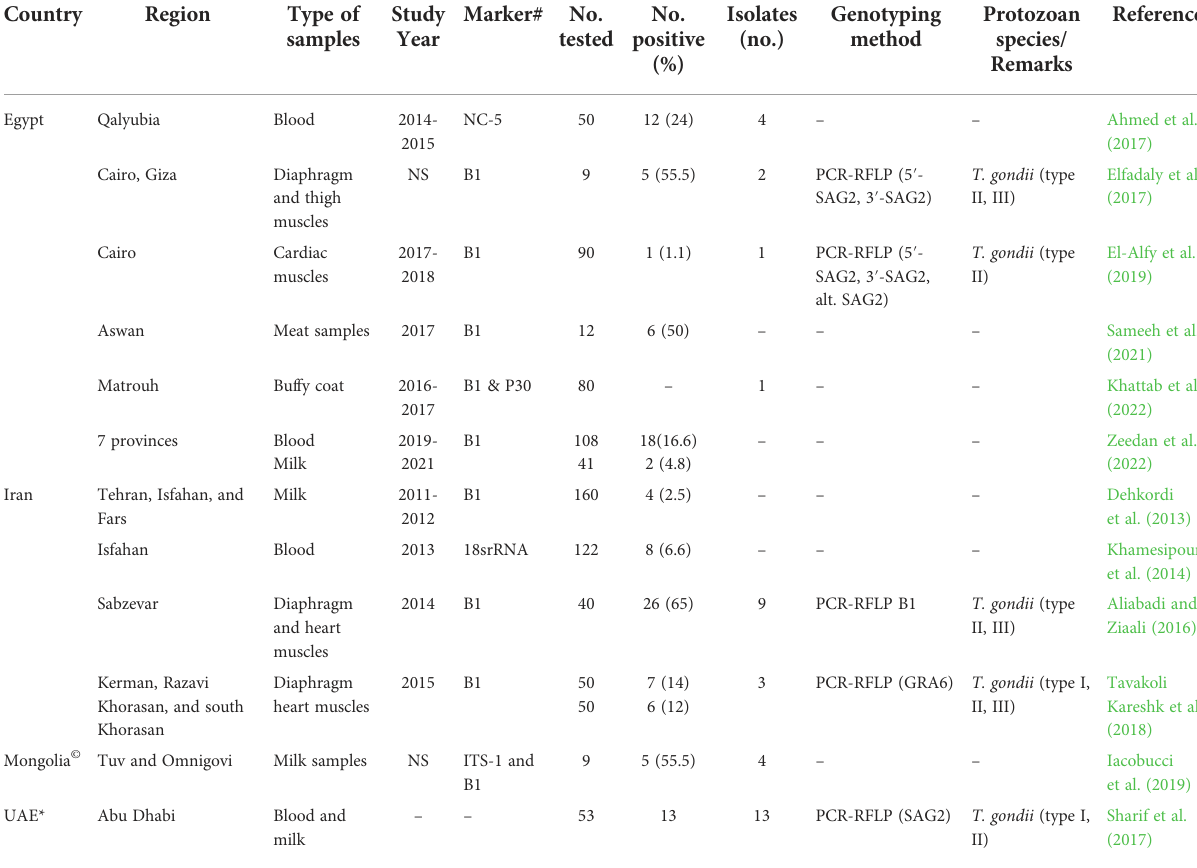
TABLE 6 Summary of molecular detection and genotyping reports for T. gondii and N. caninum infecting camels worldwide.